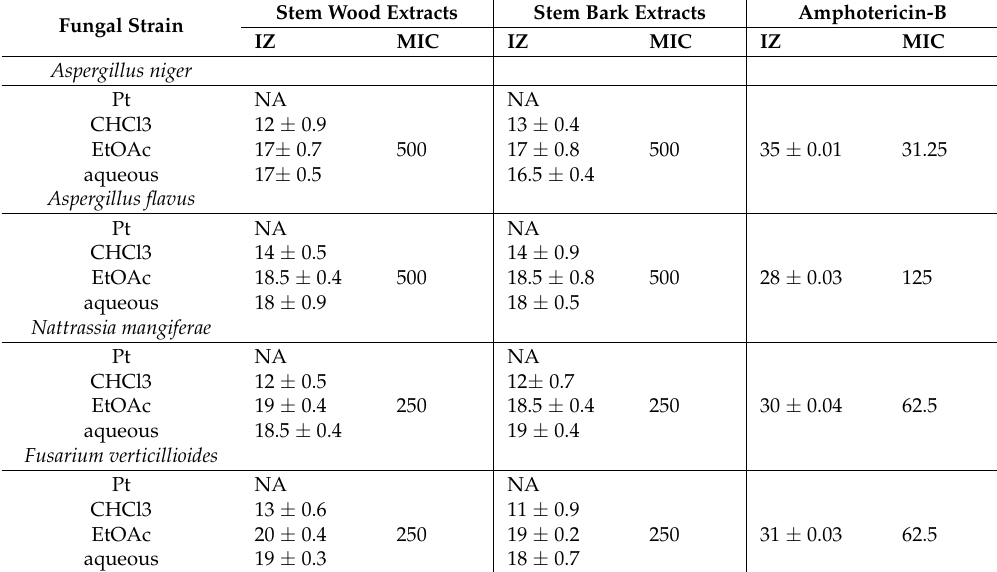
Table 1. Antifungal activity of stem wood and bark extracts of T. brownii . Results were obtained using cup well agar diffusion and agar dilution